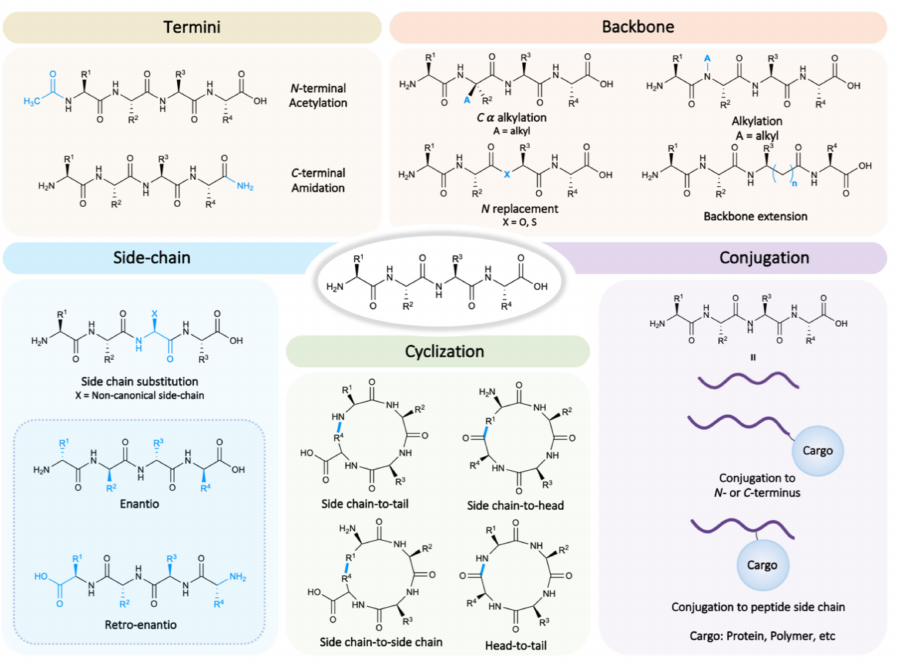
Figure 1. A plethora of strategies for enhancing peptide resistance to proteases have been